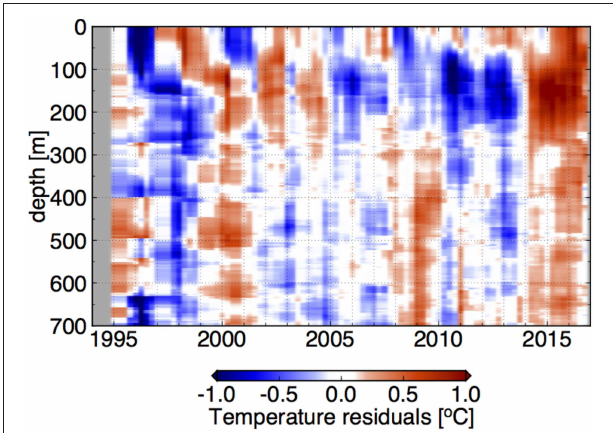
FIGURE 5 | Depth-time diagram of the average temperature residuals (seasonal cycle removed and one 1-year low-pass filter applied) in the Florida Straits using subsurface temperature profile data derived from 1,925 XBT profiles (AX07 and AXWBTS) and 541 CTD casts sampled during